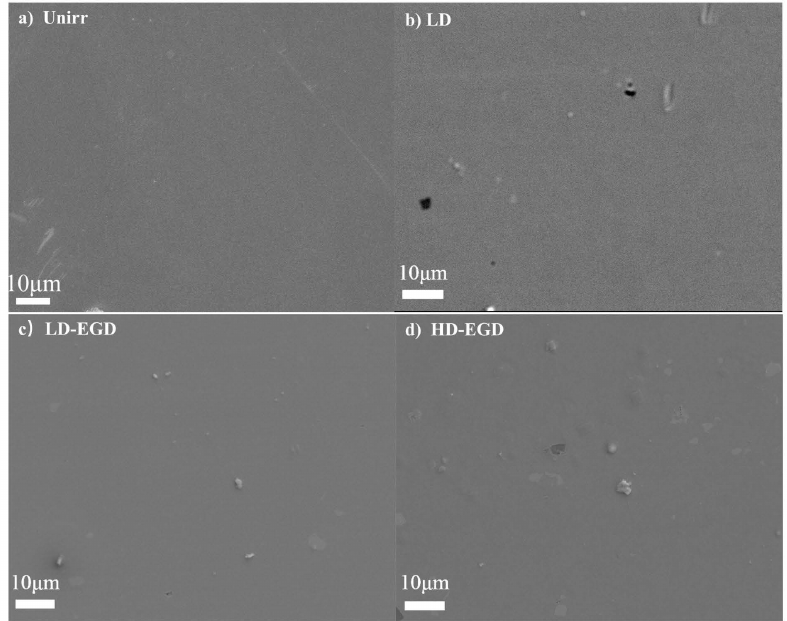
Figure 2. Surface morphology observations of different irradiated samples: ( a ) unirradiated sample, ( b ) low dose (LD), ( c ) low dose with energy gradient degrader (LD-EGD), ( d ) high dose with energy gradient degrader